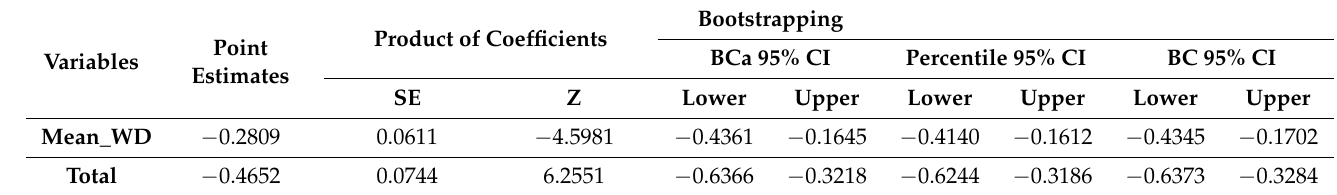
Table 6. Analysis of mediation effect with 95% confidence